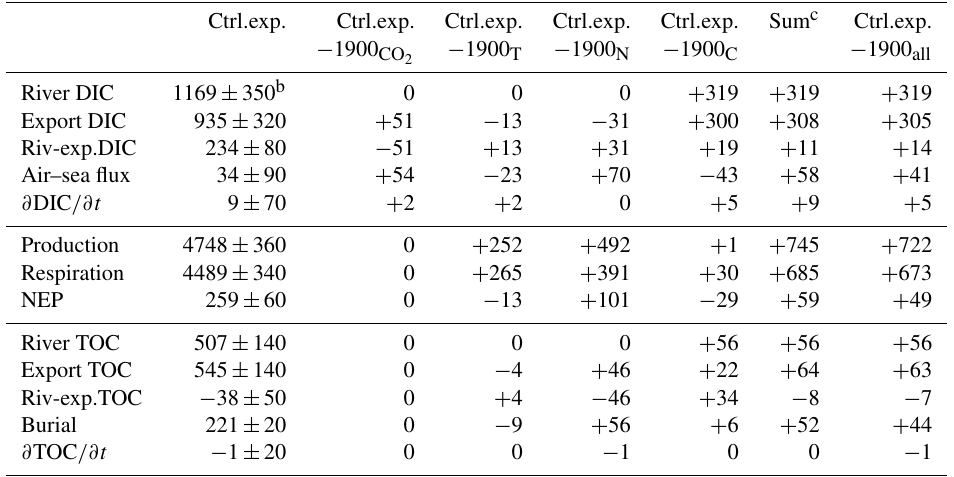
Table 4. Carbon budget terms a (Gg-Cyr − 1 ) for the control experiment (2000–2014) and deviation d of the sensitivity experiments from the control experiment (see Table 1 and Eqs. 5–7) Ctrl.exp. Ctrl.exp. Ctrl.exp. Ctrl.exp.